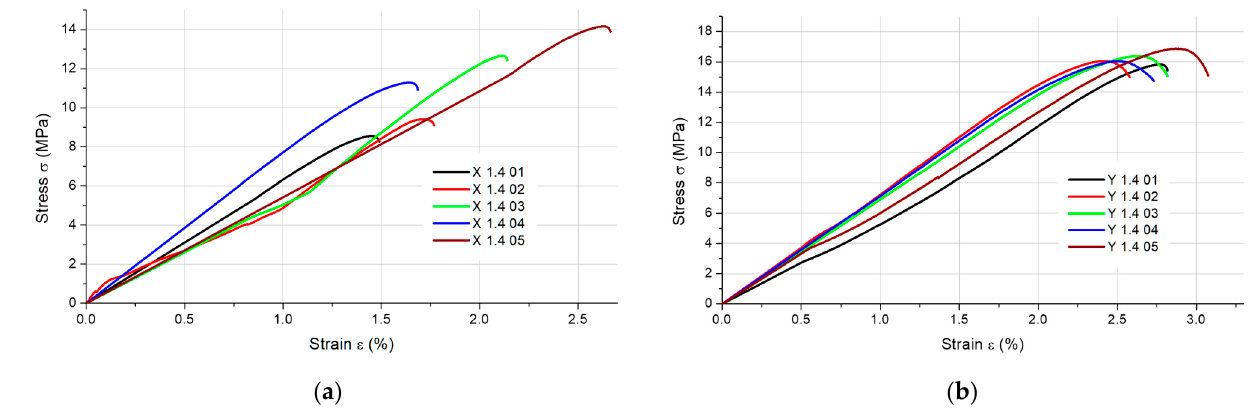
Figure 3. Stress–strain curves for the 1.4 mm thick specimens composed of PLA + bronze printed in ( a ) the X orientation and ( b ) the Y orientation.